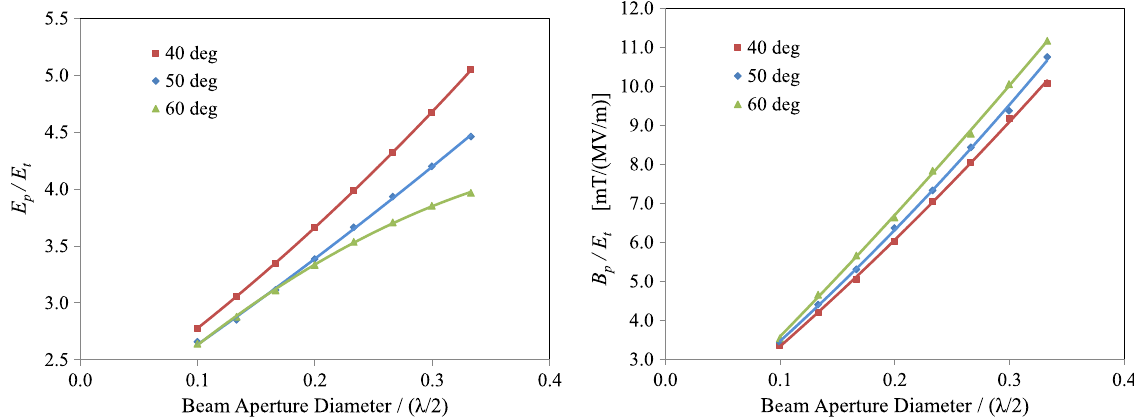
FIG. 32. Ratios of peak surface electric field ( E p ) and magnetic field ( B p ) to the transverse electric field ( E t ) with varying beam aperture diameter and angle for rf-dipole design with trapezoidal-shaped